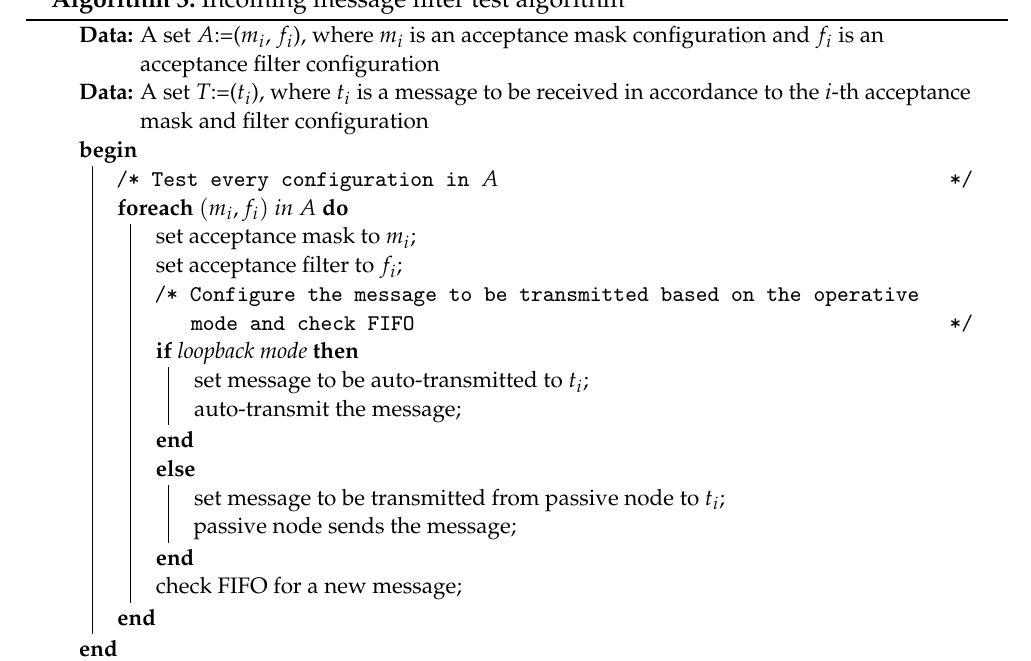
Algorithm 3: Incoming message filter test